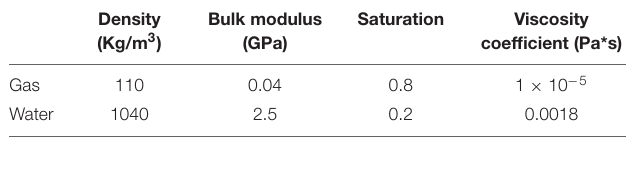
TABLE 3 | Parameters used in the patchy saturation